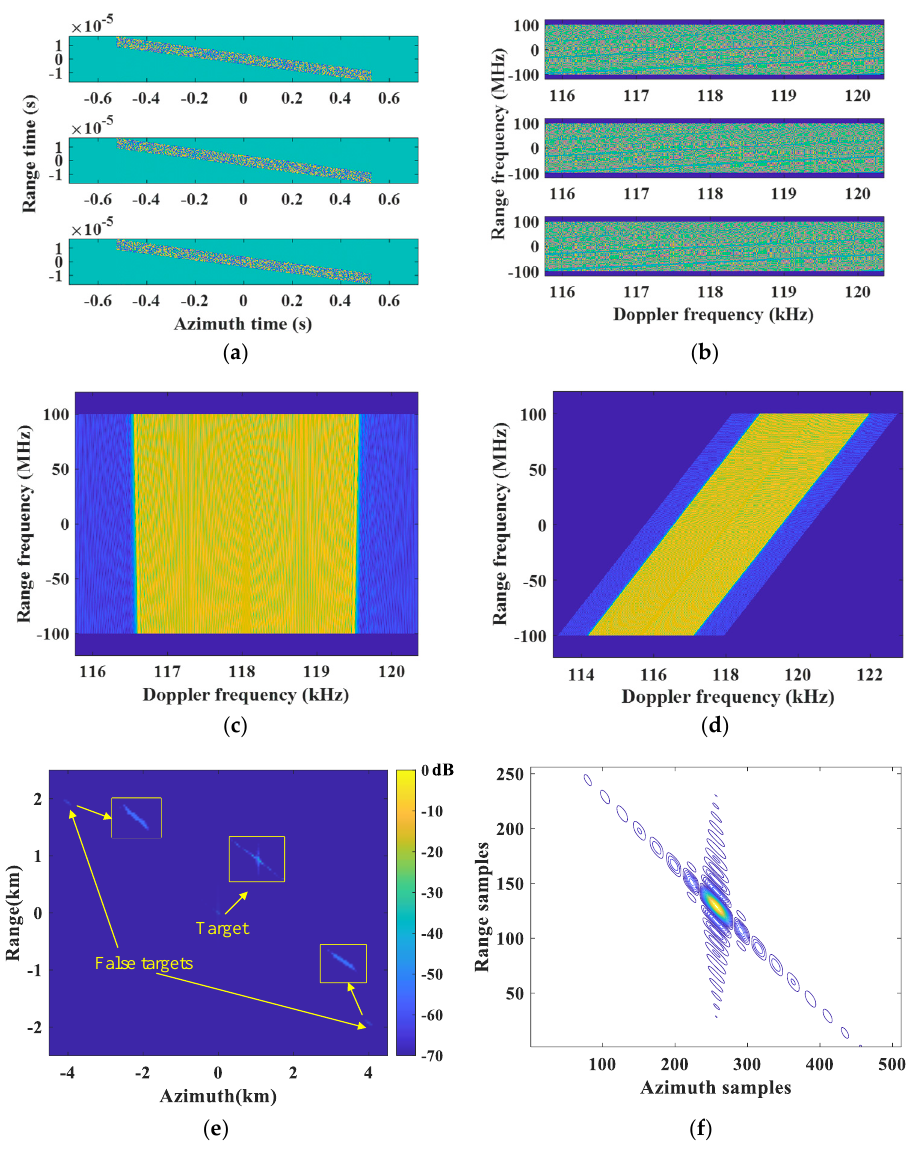
Figure 12. Simulation results of the point target in the swath center based on CHRE. ( a ) Real part of raw data; ( b ) aliased 2D spectrum; ( c ) reconstructed 2D spectrum before re-skewing; ( d ) the recovered 2D spectrum; ( e ) the focusing result; ( f ) contour plots of the point target.